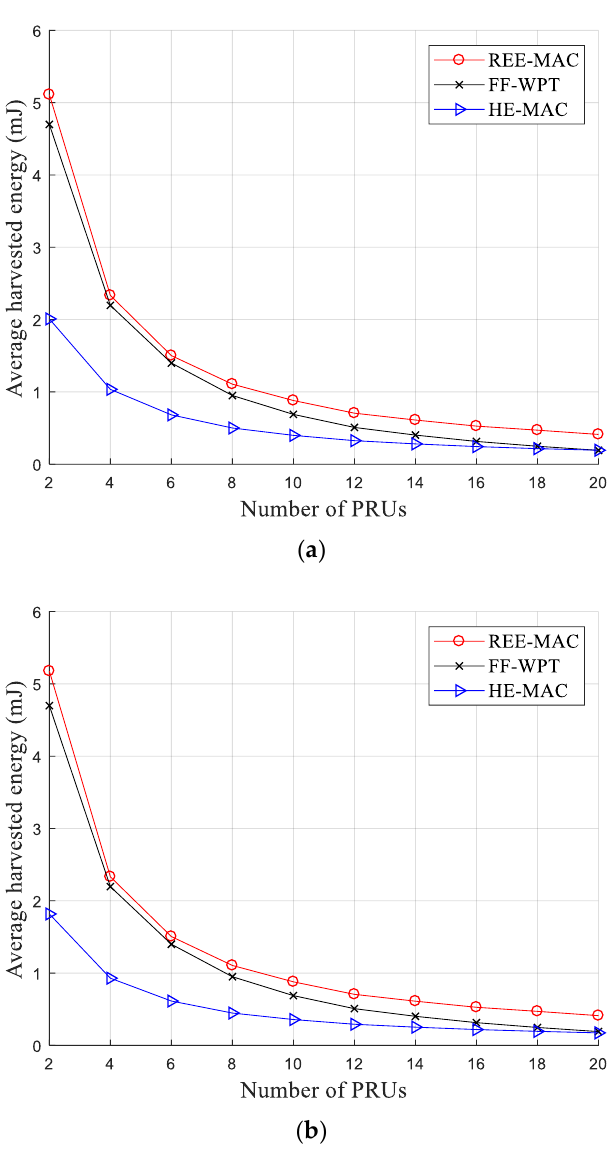
Figure 5. Average harvested energy: ( a ) packet size of 100 bytes; ( b ) packet size of 200 bytes.